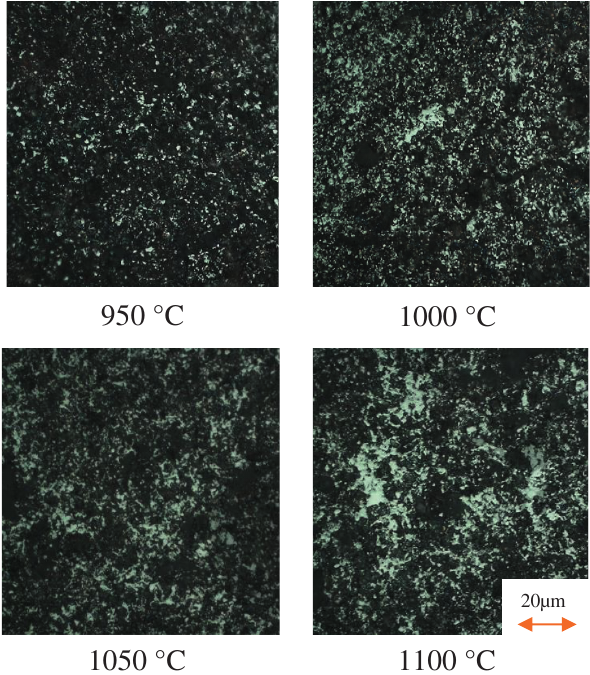
Figure 3: Microstructure of preheated pellets (white, ferric oxide).